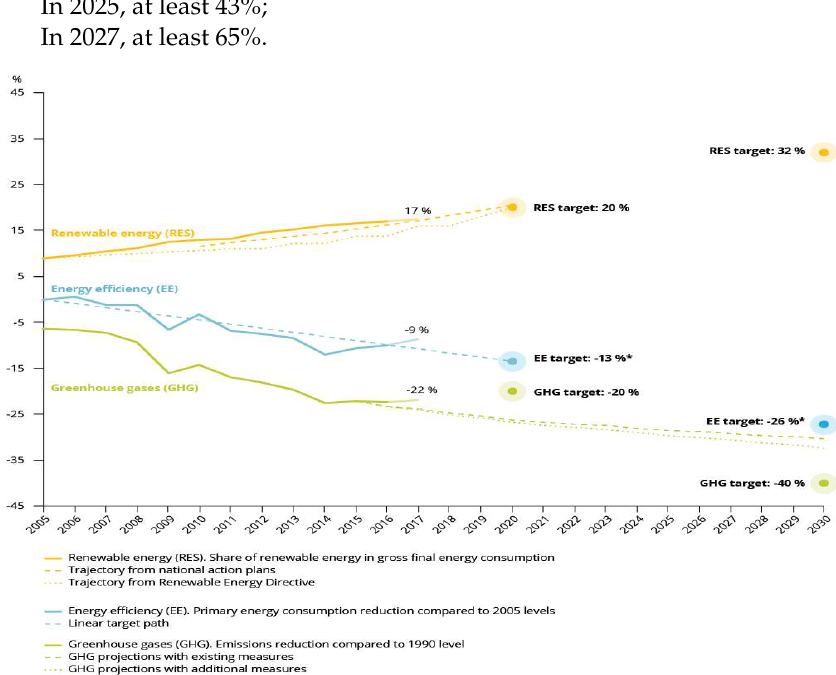
Figure 3. Selected Agenda 2030 goals. Source: [25].